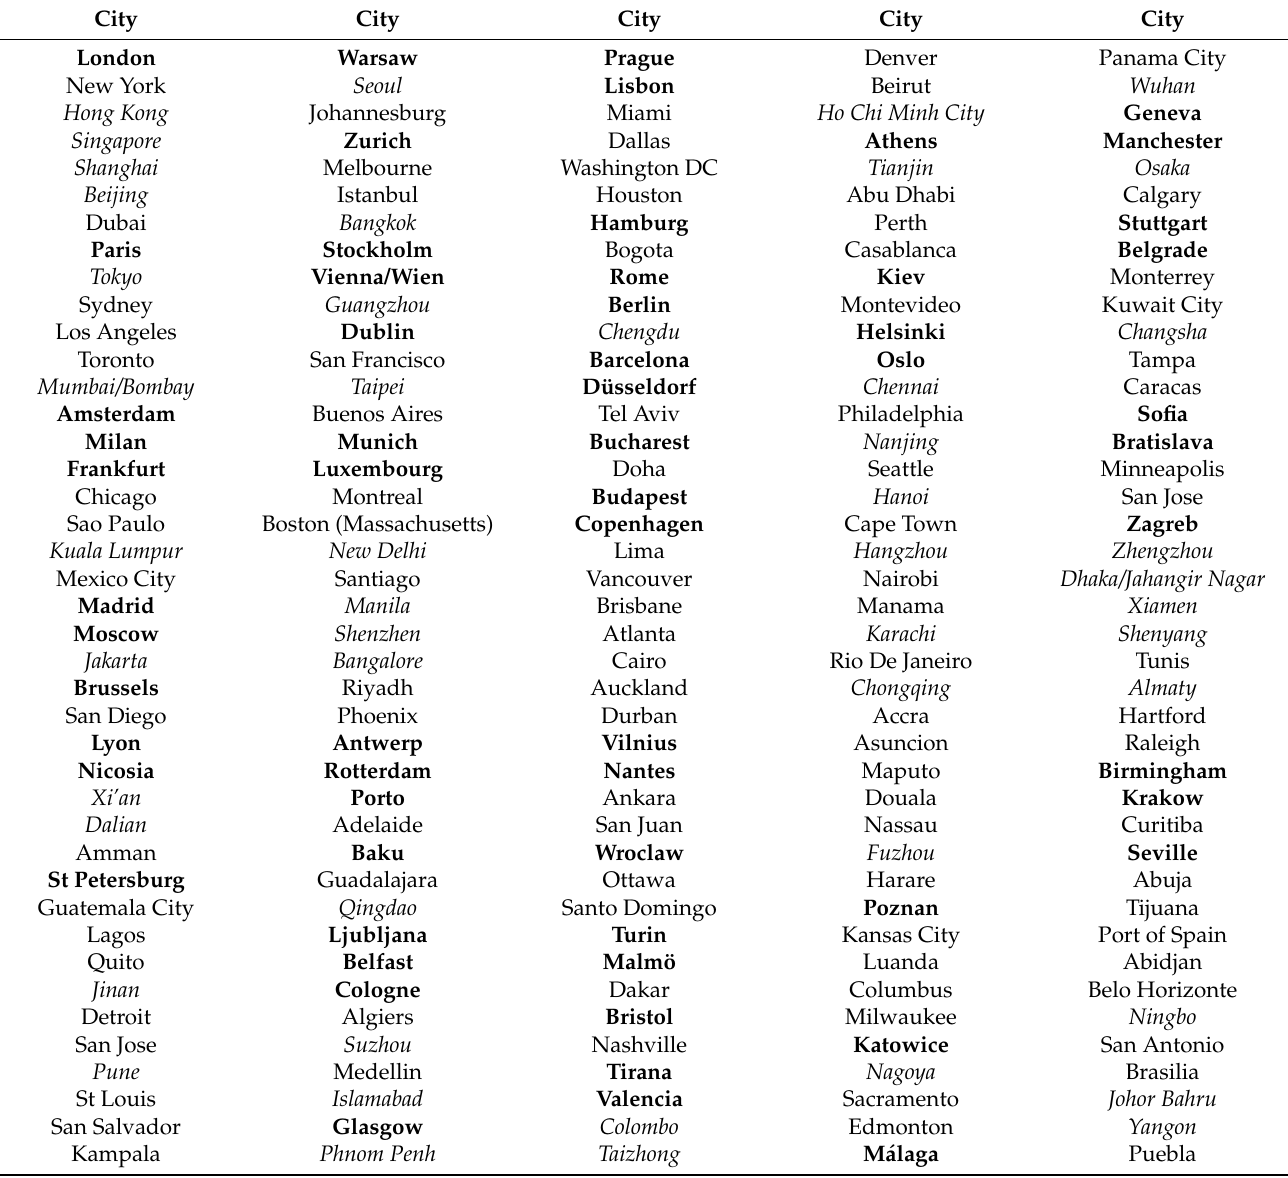
Table A2. 707 cities (European cities in bold and Asian cities in italics), rank-ordered by GNC a